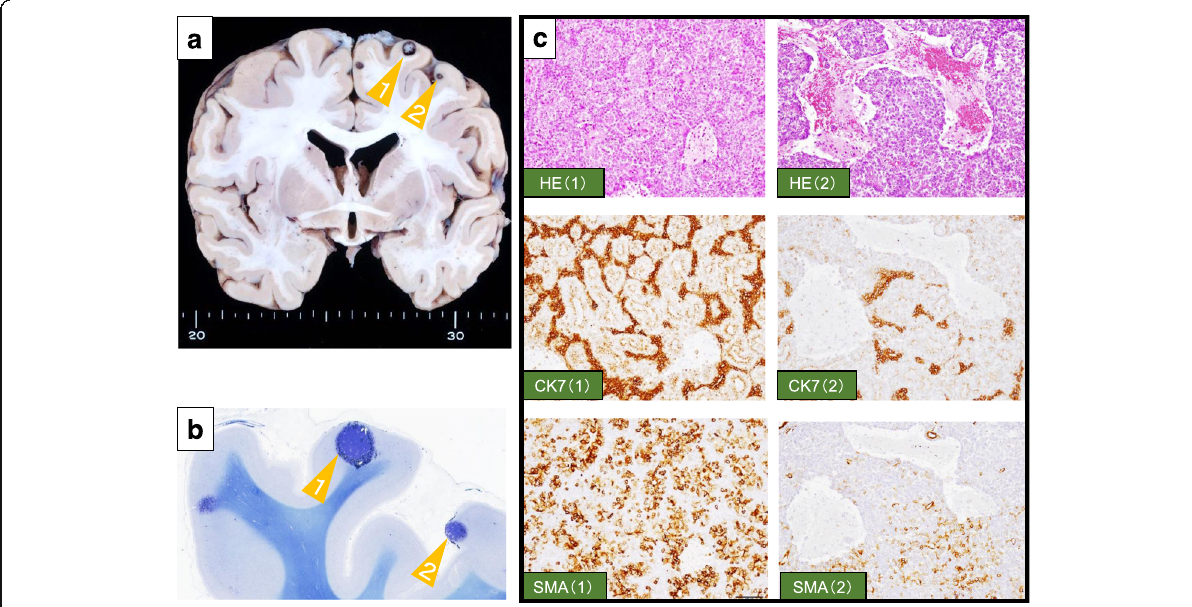
Fig. 5 Images of autopsies. a Gross specimen of brain. There are some metastatic lesions (orange arrowheads). b Histopathological findings of the brain. The tissue of the brain metastases stained with Klüver-Barrera staining. c The brain metastases (in a number 1 and number 2) were positive for CK7 and α - smooth muscle actin (SMA) retrospectively. The epithelial component was increased in the metastatic lesions compared to the primary breast